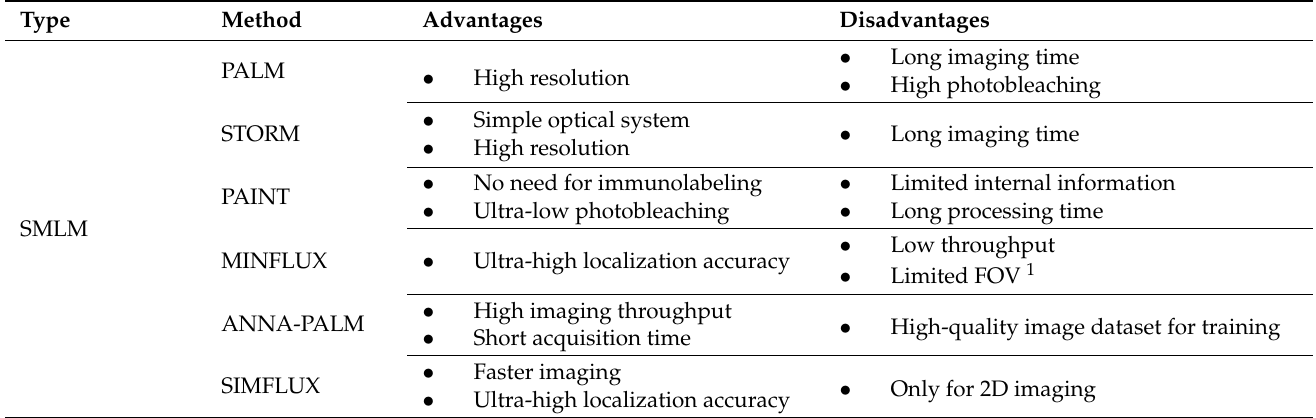
Table 4. Comparing the advantages and disadvantages of representative SRM